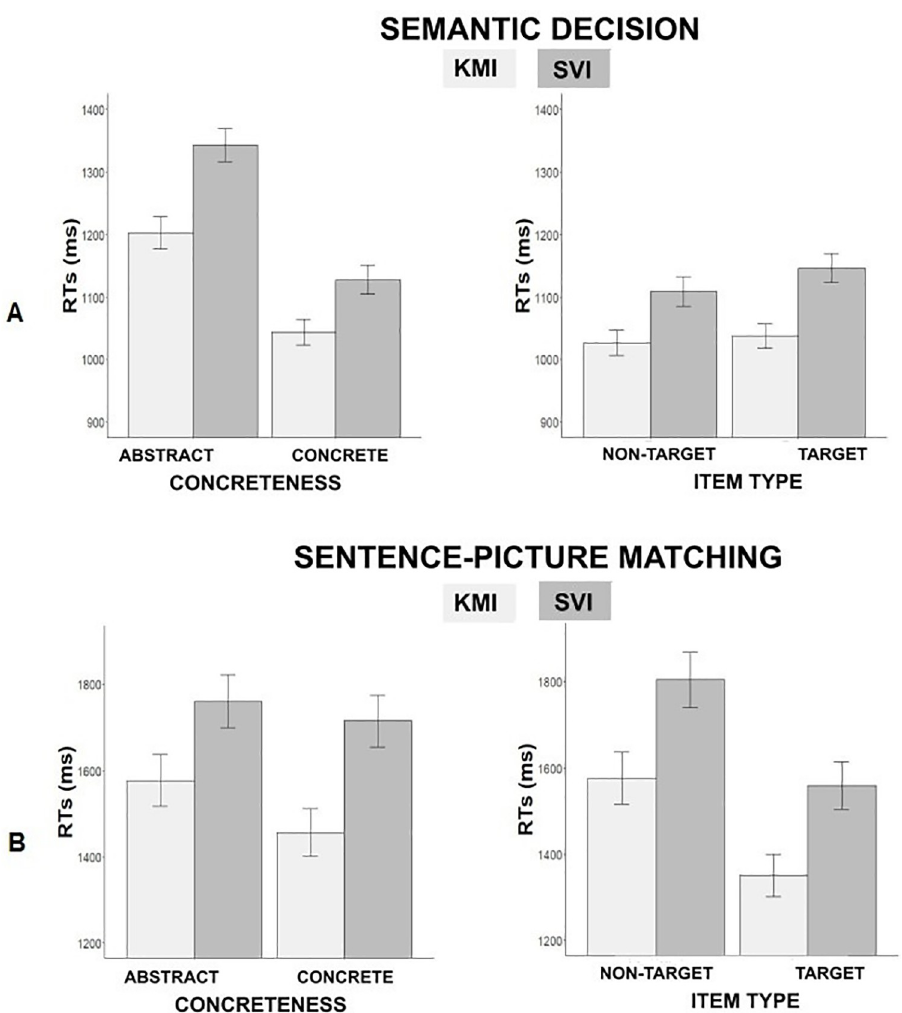
Fig 3. Results of Experiment 2. Index of Performance Improvement (IPI in %, computed as: IPI = ([pre-training RT– post-training RT] / pre-training RT) � 100)) for both semantic categorization (A) and sentence-picture matching (B) tasks. Error bars represent standard errors of the